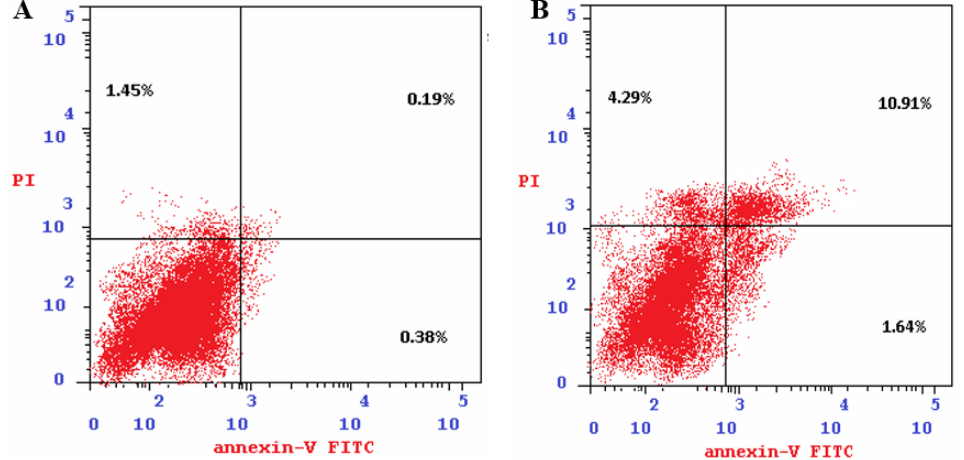
Figure 6. Effect of compound 6b on the percentage of annexin propidium iodide-positive staining in HepG2 cells. ( A ) Control cells. ( B ) Cells treated with compound 6b .